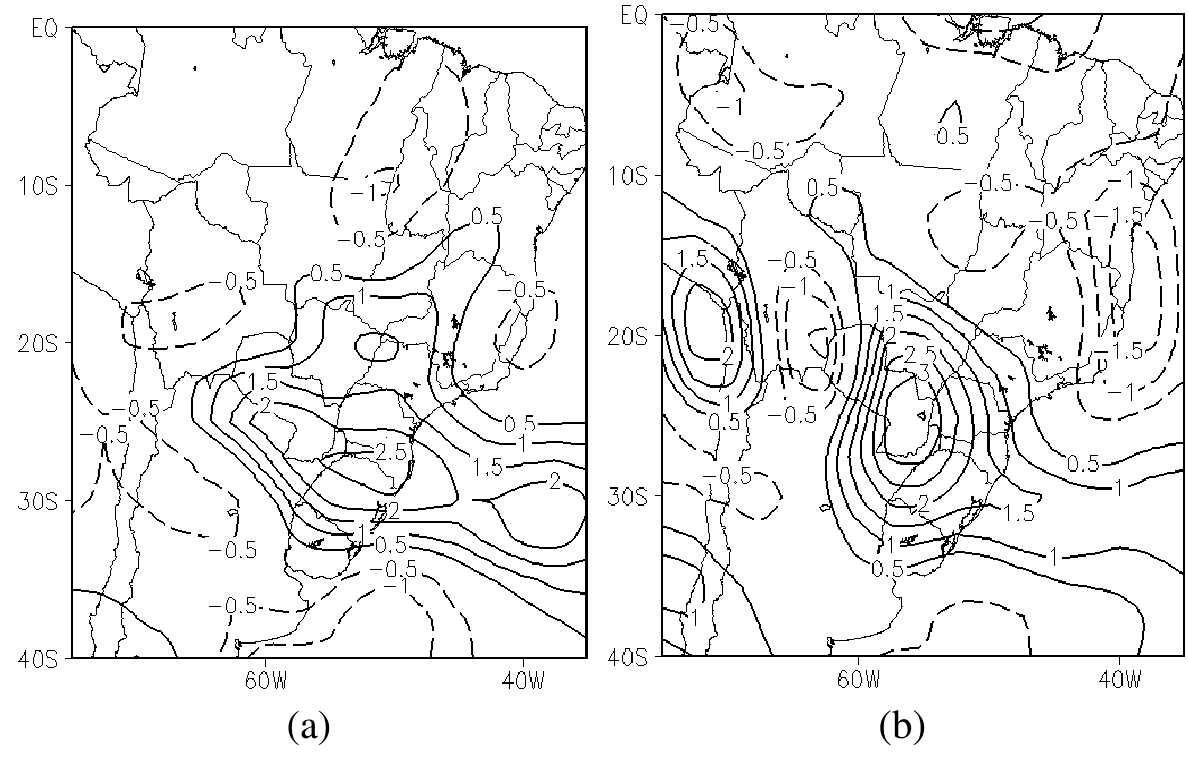
Fig. 20 - Composite fields of (a) horizontal thermal advection and (b) vertical thermal advection, at 850 hPa for the 17 strongest WDSs. Units are in ° C day -1 .